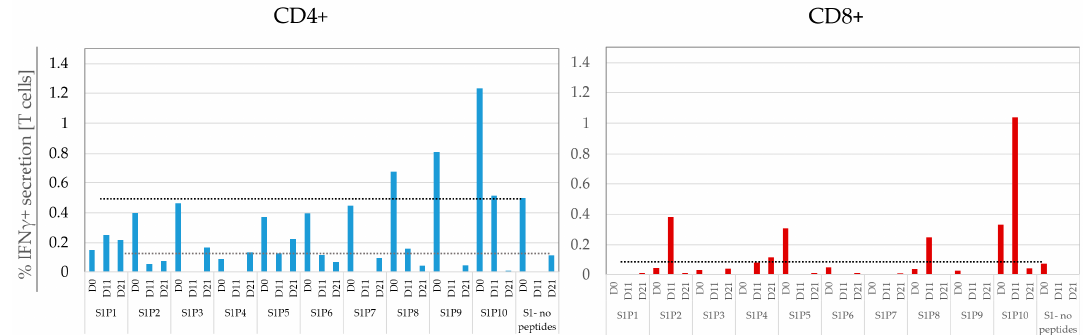
Figure 4. FCM detection of IFN γ secretion to vaccine-peptides: A glioma patient’s PBMC were cultured with or without vaccine peptides overnight and stained by means of a T-cell polyfunctional panel. Bar graphs show IFN γ secretion of CD4+ and CD8+ T cells to Set 1 (S1) peptides. Repeated with 3 different sets of samples with similar results. A dotted reference line is drawn from the non-zero no-peptides groups.